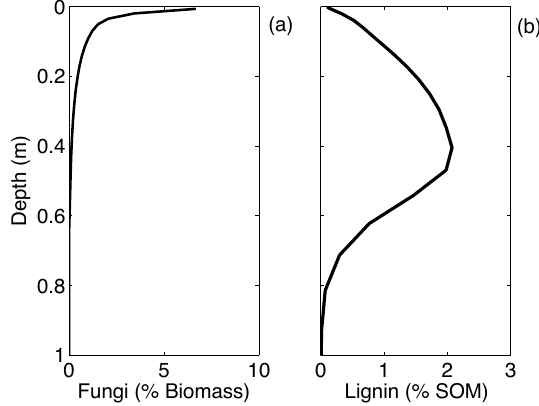
Figure 5. Proportion of biomass that is fungal (a) and proportion of total SOM that is lignin (b) as functions of